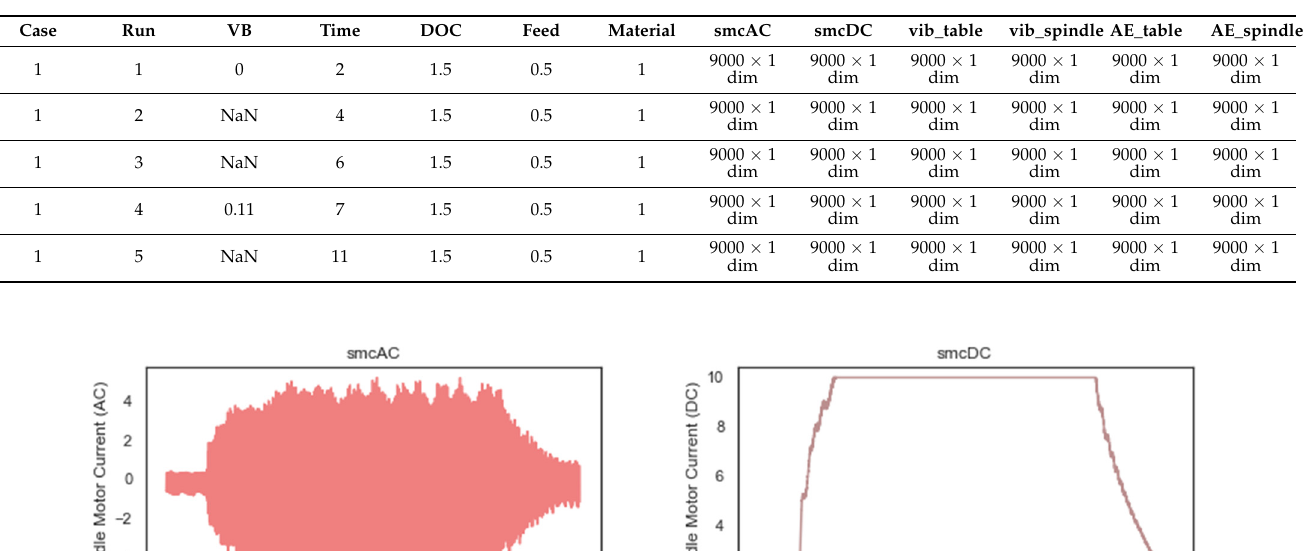
Table A1. Snapshot of the dataset.